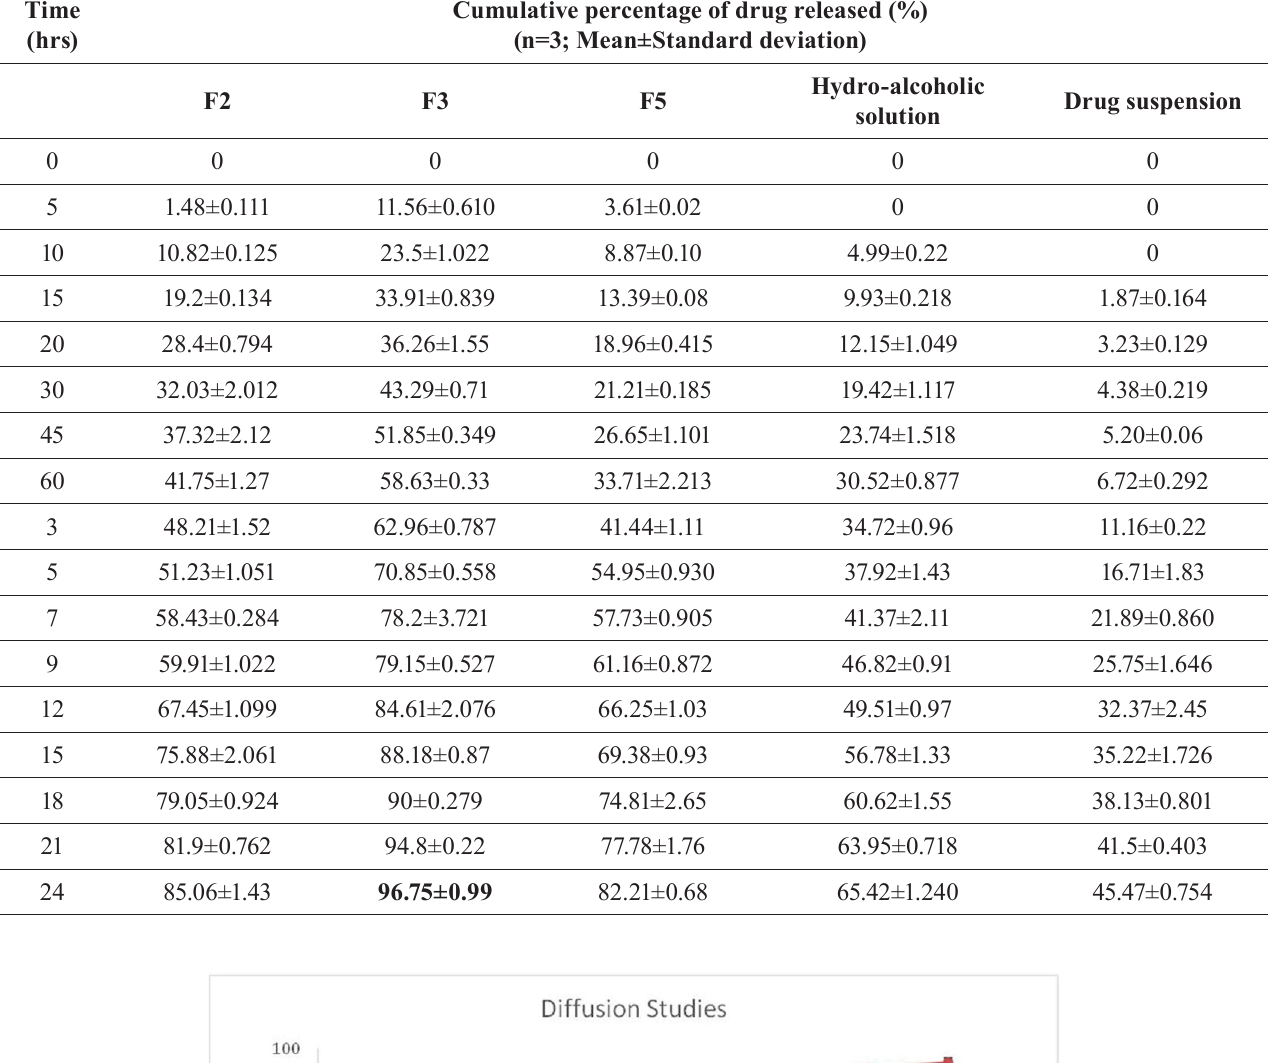
TABLE III - In vitro diffusion studies data of selected F2, F3 and F5 ethosomes and its comparison Time (hrs)